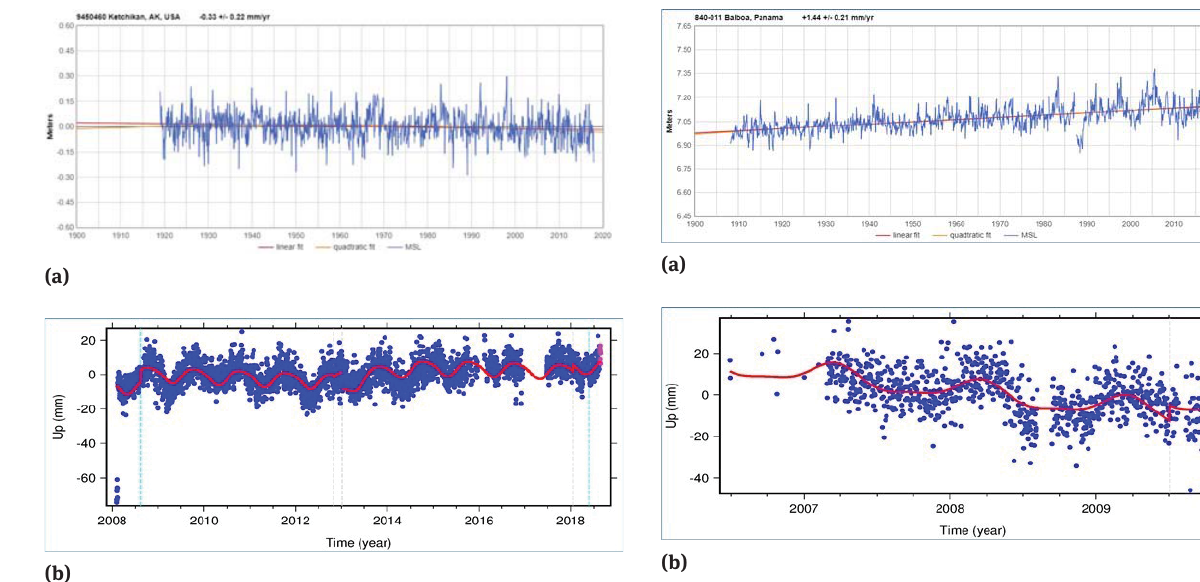
Figure 21: (a) MSL data for San Diego, CA, USA. Image reproduced modified after [4]. (b) GNSS time series for PLO5. Image reproduced modified after NGL.